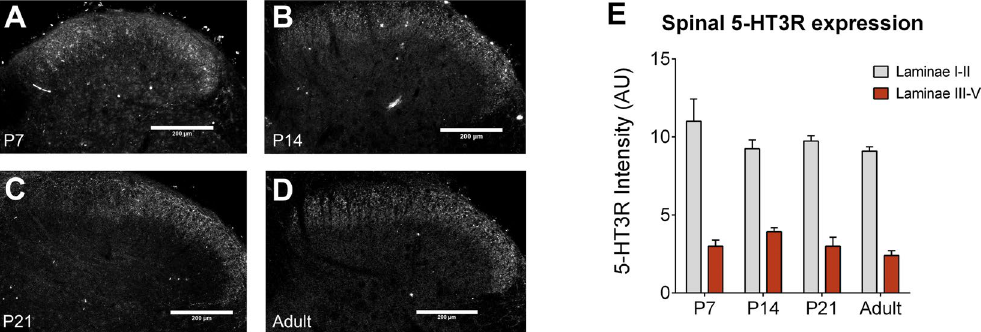
Figure 3. 5-HT 3 receptors are expressed in the lumbar dorsal horn from P7. Immunohistochemical labelling of 5-HT 3 R was performed at P7 ( A ), P14 ( B ), P21 ( C ) and in adults ( D ). Scale bar = 250 μ m. 5-HT 3 R labelling was observed predominantly in laminae I-II in the dorsal horn from P7 and this distribution did not change with age. Quantification of 5-HT 3 R intensity was performed in laminae I-II and in laminae III-V and revealed no change in 5-HT 3 R intensity with age ( E ). Bars indicate mean ±